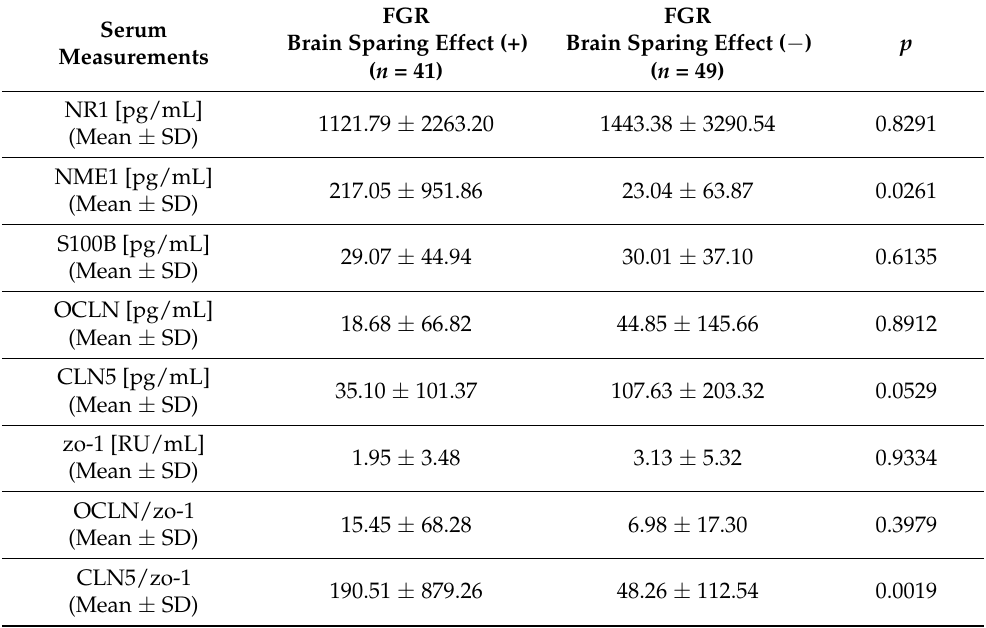
Table 3. Serum concentrations of the biochemical parameters in a FGR pregnancy in the presence or absence of the brain sparing effect.